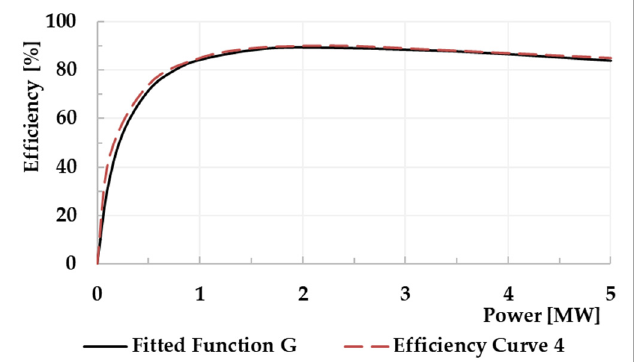
Figure 4. Fitted function G based on the value of change points in Table 3.